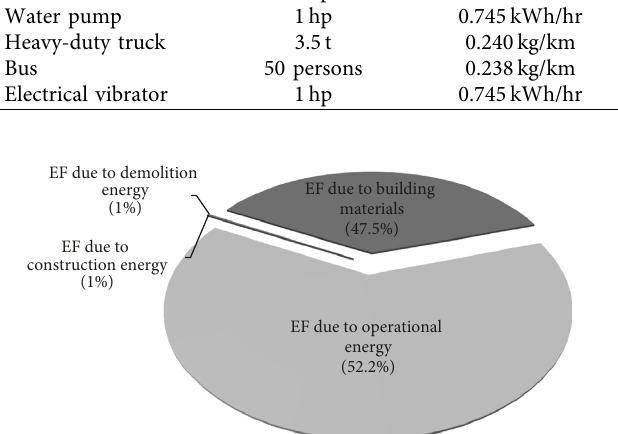
Figure 4: Fraction of the EF